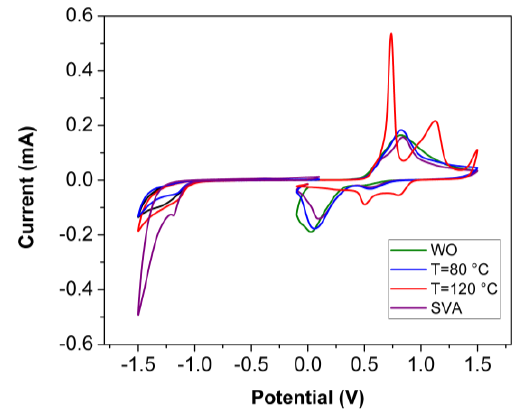
Figure A1. Cyclic voltammetry of DRCN5T films at different post-treatments.